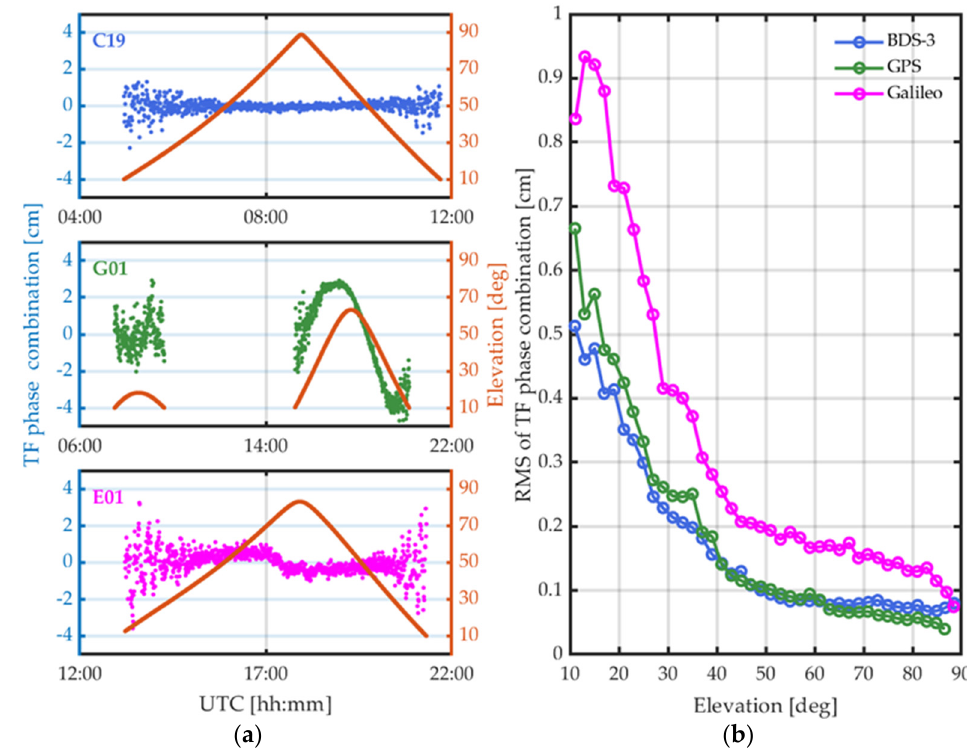
Figure 3. ( a ) Time series of the TF phase combination extracted by the observations from C19, G01, and E01. ( b ) The RMS of TF phase MP vs. elevation angle of BDS-3, GPS, and Galileo computed with the whole constellation that can be tracked of every 2° of elevation with inter-frequency clock bias (IFCB) corrected by the baseline GODN-GODS.